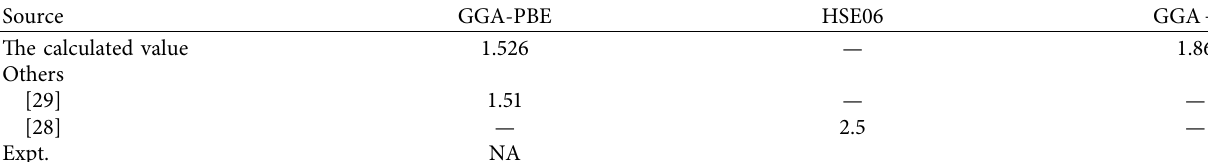
3 in comparison to the existing works.